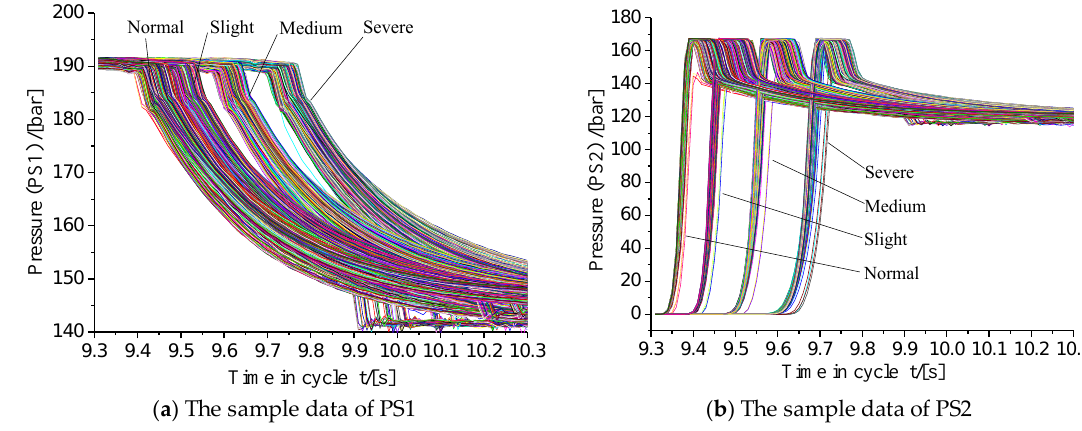
Figure 3. The sample data of the hydraulic valve fault diagnosis.